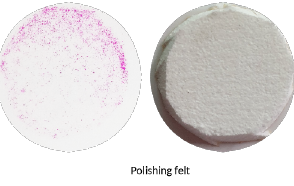
Figure 4. Discoloration of the fi lm after pressure loading on a fl at surface with a polishing felt (left) and the polishing felt (right).